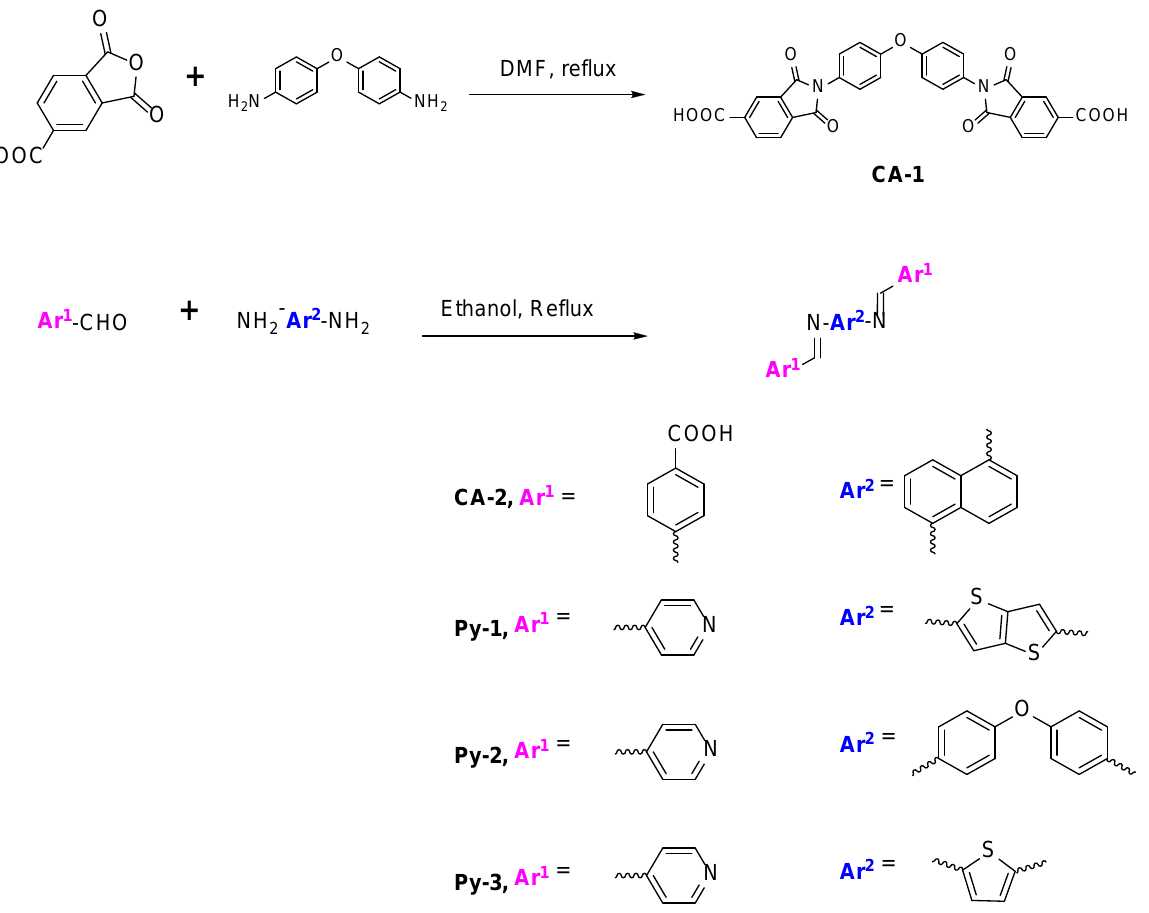
Scheme 1. Synthesis of diimide CA-1 and Schiff bases CA-2 and Py-1-3.